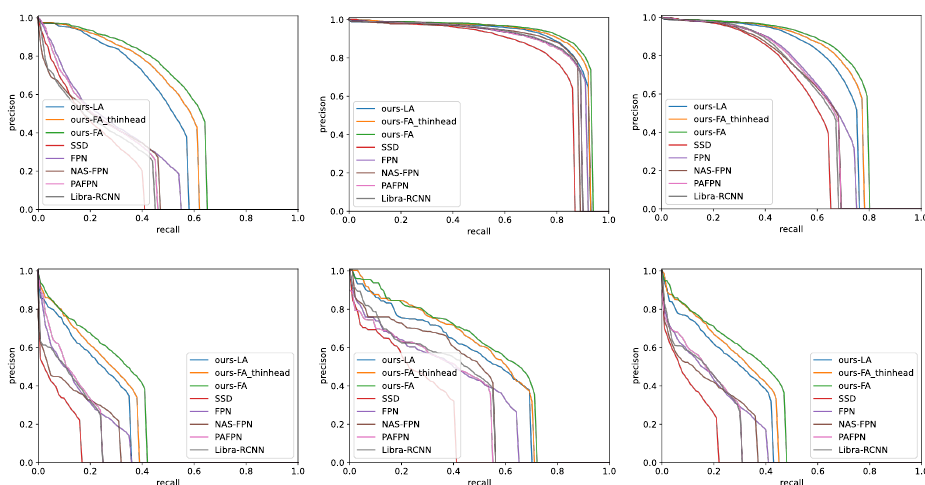
Figure 10. The precision–recall (PR) curves of car (first row) and motor (second row). ( a ) The PR curve of small objects. ( b ) The PR curve of medium objects. ( c ) The PR curve of all